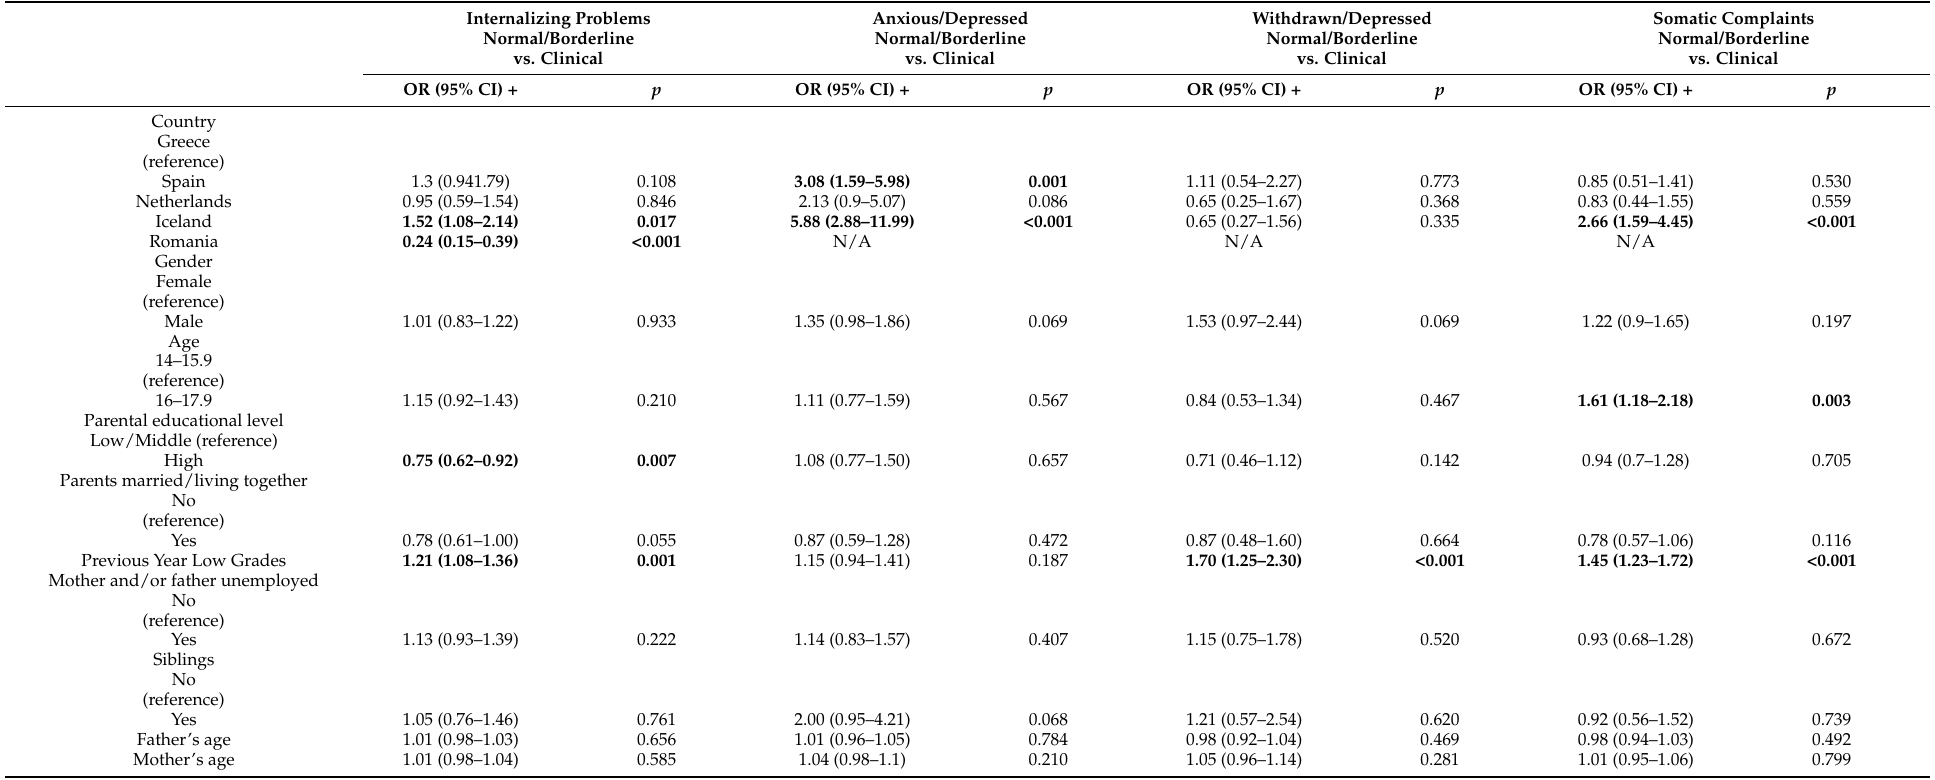
Table 3. Results from multiple logistic regression analysis with clinical internalizing problems (in all subscales and in total) as the dependent variable in the total sample. Bold cells denote statistically significant